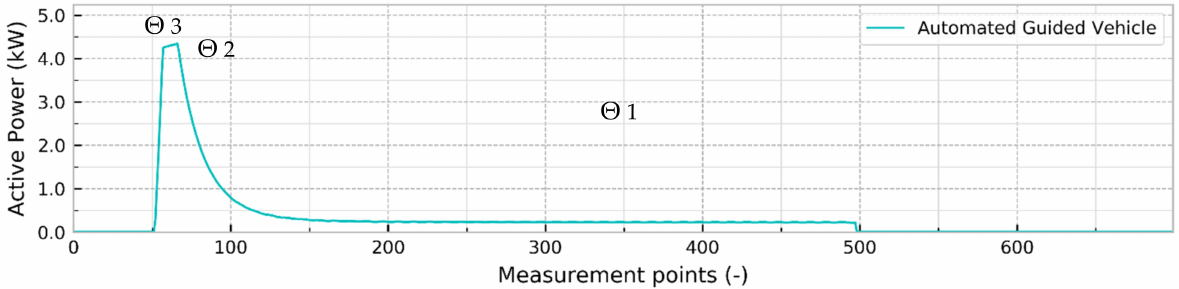
Figure 2. Time series of the power during a charging process of the AGV. Θ 3 is the ‘ CC charging ’ mode, consuming the highest amount of power, Θ 2 decodes the ‘ CV charging ’ mode with reduced power consumption and Θ 1 is the ‘ idling ’